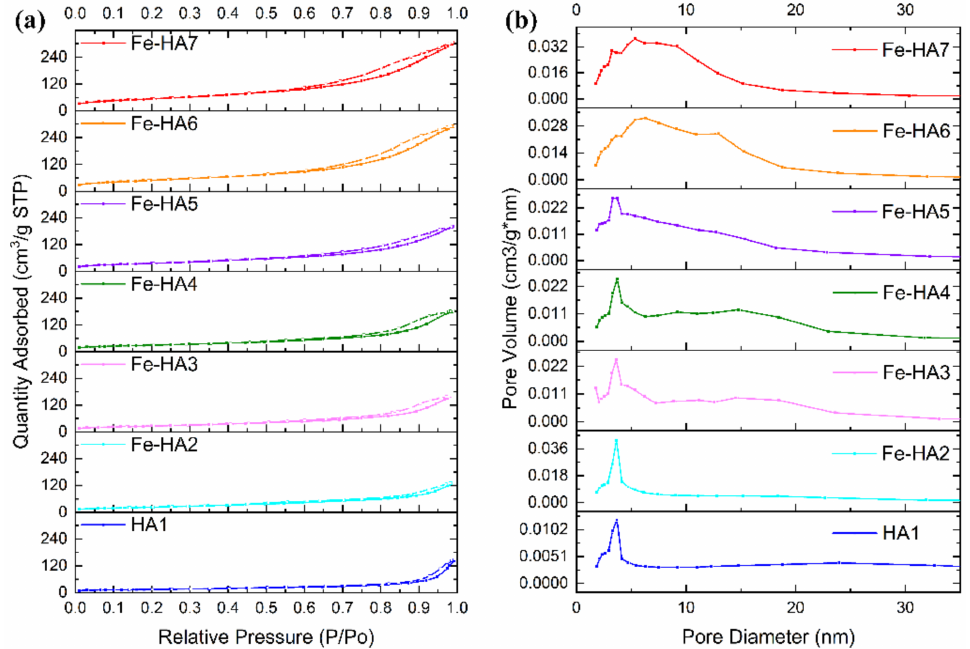
Figure 6. Nitrogen adsorption-desorption isotherms ( a ) and pore size distributions ( b ) of HA and Fe-HA powders. Table 3. BET Specific Surface Area, pore volume, and adsorption average pore diameter for the synthesized samples.